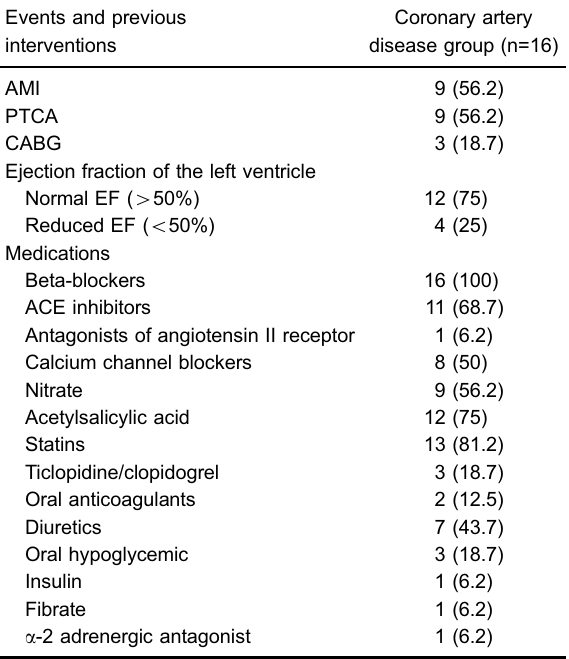
Table 2. Events and previous interventions, distribution of left ventricular ejection fraction, and medications being used in the coronary artery disease